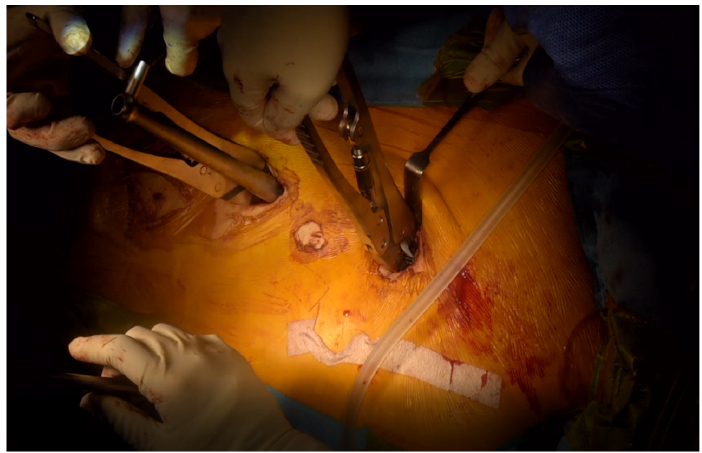
Figure 4. Deformity correction technique with derotation